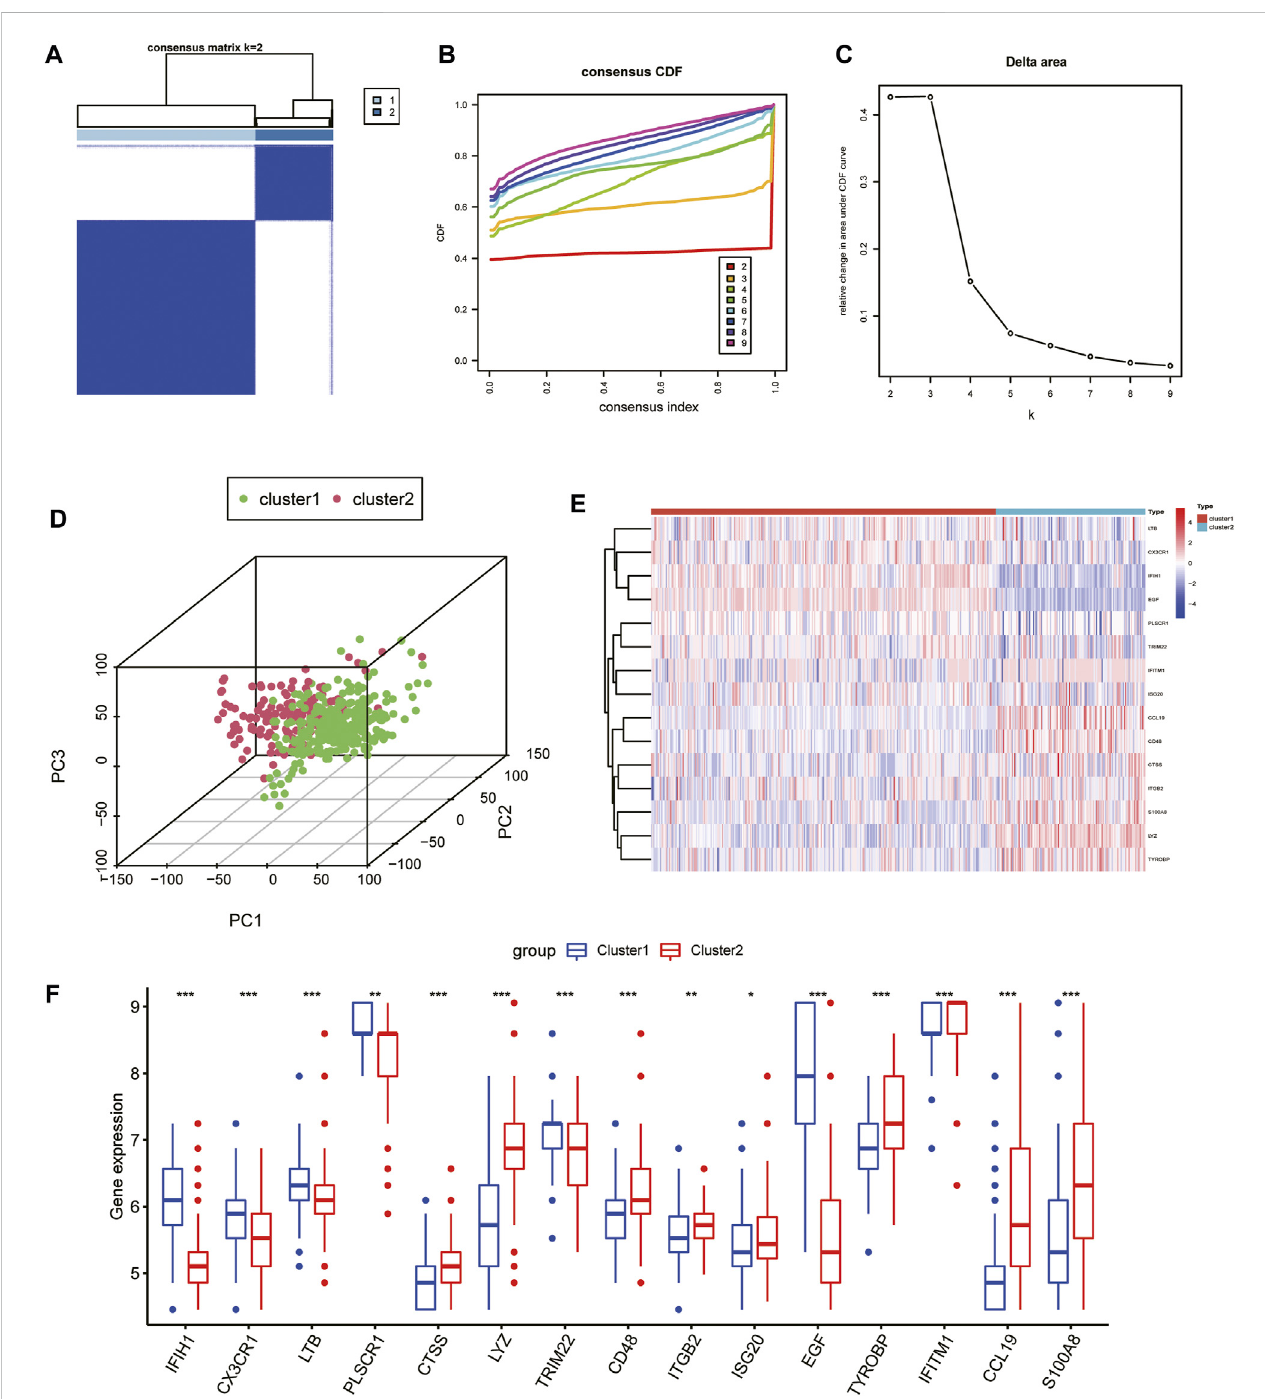
FIGURE 4 UnsupervisedconsensusclusteringinCKDsamplesbasedonIRGs. (A) ConsensusclusteringmatrixdisplayingthetwoCKDsampleclusterswithk=2. (B) Cumulativedistributive function for k = 2 to 9. (C) Delta graph displaying the change in theCDF curve ’ sarea from k = 2 to 9. (D) PCA scatter plot based on the results of cluster analysis. (E, F) Heatmap (E) and box plots (F) of 15 IRGs among the two clusters. *** p < 0.001; ** p < 0.01; and * p <